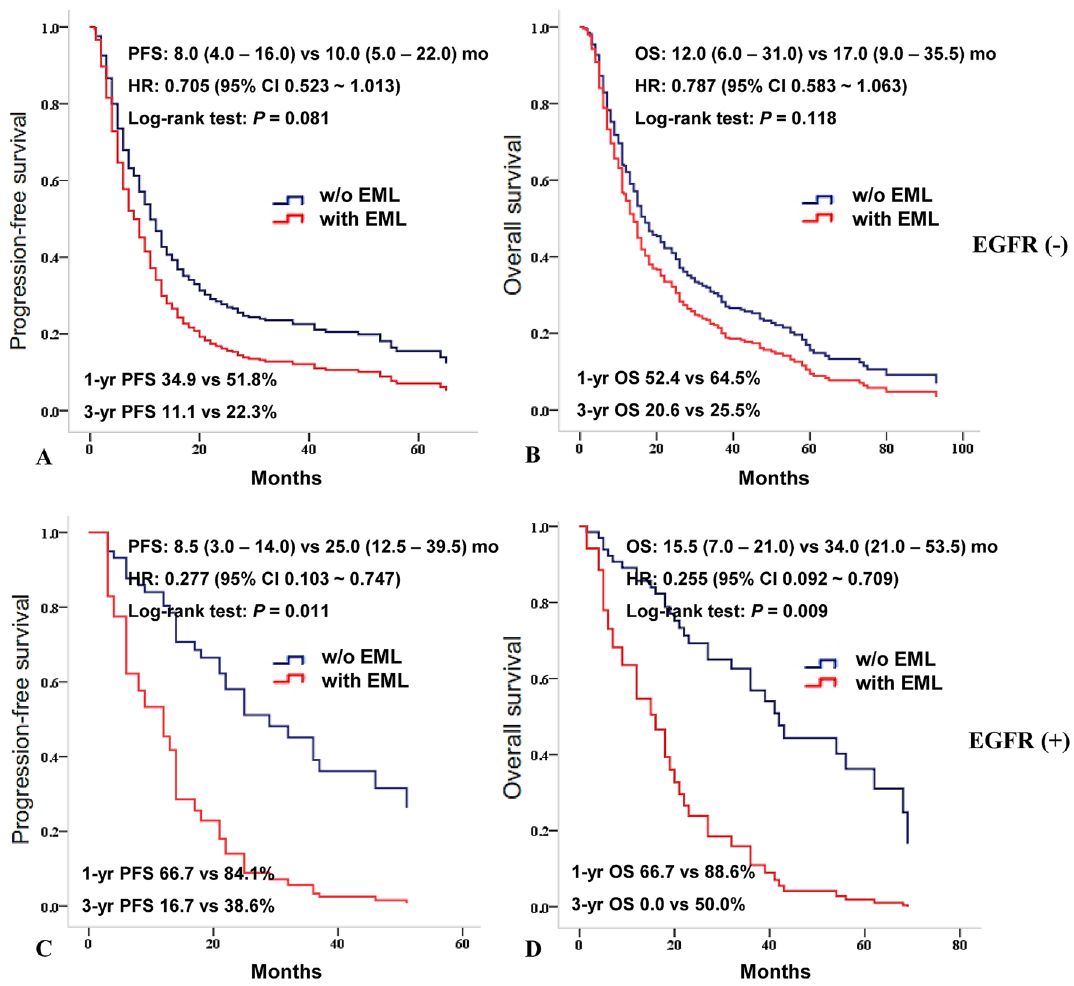
Figure 3. Median PFS and OS according to EML when EGFR negative or positiveWhen compared PFS and OS according to EML in case of EGFR negative, PFS ( A ) and OS ( B ) were not significantly different as median PFS was 8.0 (4.0–16.0) versus 10.0 (5.0–22.0) months (HR = 0.705, 95% CI 0.523–1.013, P = 0.081, ( A ), and median OS was 12.0 (6.0–31.0) versus 17.0 (9.0–35.5) months (HR = 0.787, 95% CI 0.583–1.063, P = 0.118, ( B ). When EGFR was positive, PFS ( C ) and OS ( D ) were significantly lower in patients with EML compared to patients without EML as median PFS was 8.5 (3.0–14.0) versus 25.0 (12.5–39.5) months (HR = 0.277, 95% CI 0.103– 0.747, P = 0.011, ( C ), and median OS was 15.5 (7.0–21.0) versus 34.0 (21.0–53.5) months (HR = 0.255, 95% CI 0.092–0.709, P = 0.009, ( D ). EGFR epidermal growth factor receptor, EML endobronchial metastatic lesion, HR hazard ratio, mo months, OS overall survival rate, PFS progression-free survival rate, vs.